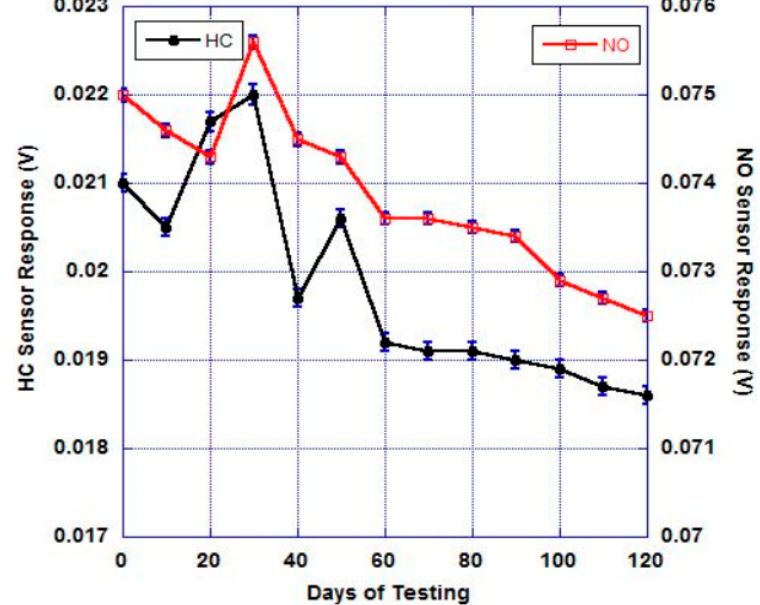
Figure 7. Long-term testing of the sensor (25 ppm, 200 °C, 500 sccm). A decrease in HC and NO mixed-potential sensitivity was observed after 120 days of testing. The error bars indicate three trials of analyte exposure. Humidity was not added in this experiment.